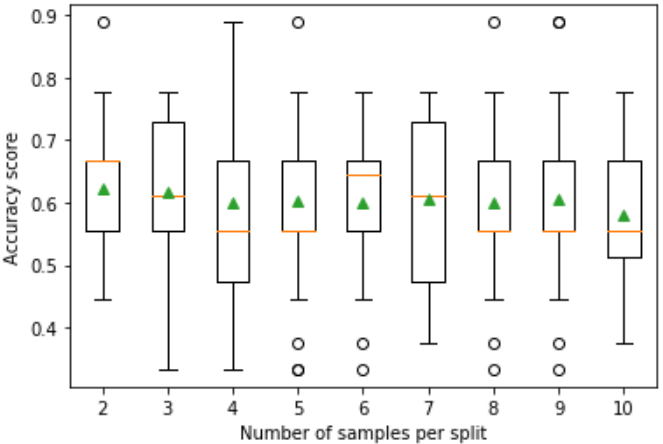
Figure 25. Pohang: Boxplot to illustrate the mean accuracy distribution by hyper-tuning the minimum number of samples per split.